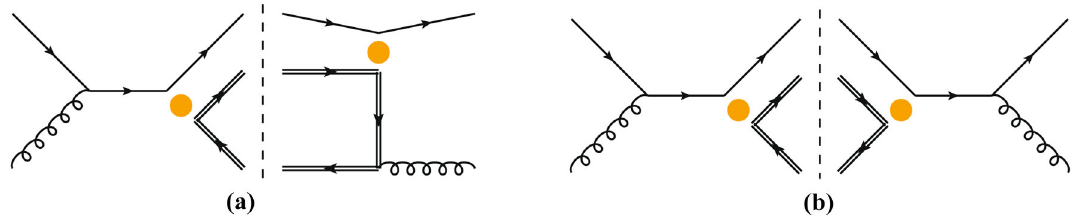
Fig. 1 Examples of contributions to the energy asymmetry in terms of Contributions to the asymmetry in QCD are obtained by replacing the orange filled circles in the left diagram by gluons. Further details about Feynman diagrams. The double lines indicate top quarks; the orange the QCD prediction and SMEFT contributions can be found in Ref. [18] filled circles stand for possible insertions of four-quark operators in and Ref. [19], SMEFT. The dashed line symbolizes the interference M 1 M ∗ of the 2 two qg → t ¯ tq amplitudes M 1 and M ∗ to its left and right sides. 2